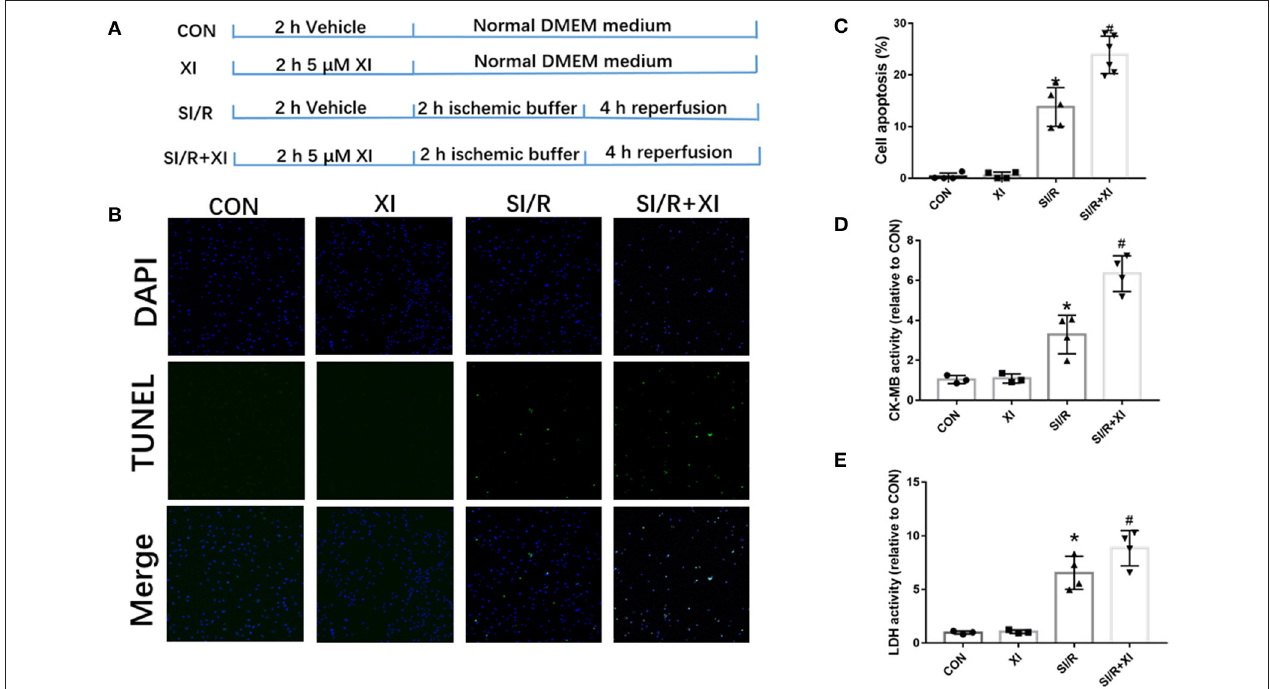
FIGURE 5 | 4 µ 8C, an XBP1 inhibitor, increased H9c2 cell apoptosis LDH and CK-MB activities in vitro . (A) A schematic illustration of the study groups and in vitro experimental protocols. (B) Representative images of cell apoptosis by TUNEL staining in SI/R-induced cell injury following 4 µ 8C pretreatment. (C) The quantitative analysis of cell apoptosis following 4 µ 8C pretreatment. Eight random fields were selected for quantitation of cell apoptosis for each repeat experiment. (D) LDH activity. (E) CK-MB activity. n = 3–4 in each group. XI, XBP1 inhibitor; LDH, lactate dehydrogenase; CK-MB, creatine kinase-MB; SI/R, stimulated ischemia/reperfusion. Bar, 50 µ m. * P < 0.05 vs. CON group, # P < 0.05 vs. SI/R